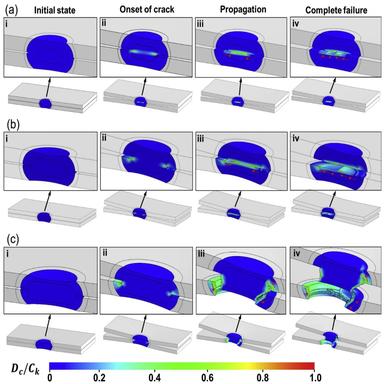
Evolution of damage accumulation index Dc/Ck and the crack propagation process during the tensile-shear tests. (a) Case-1; (b) Case-2; and (c) Case-3. Note that the subfigures i-iv correspond to the initial, onset of crack, crack propagation, and complete failure states in each case.